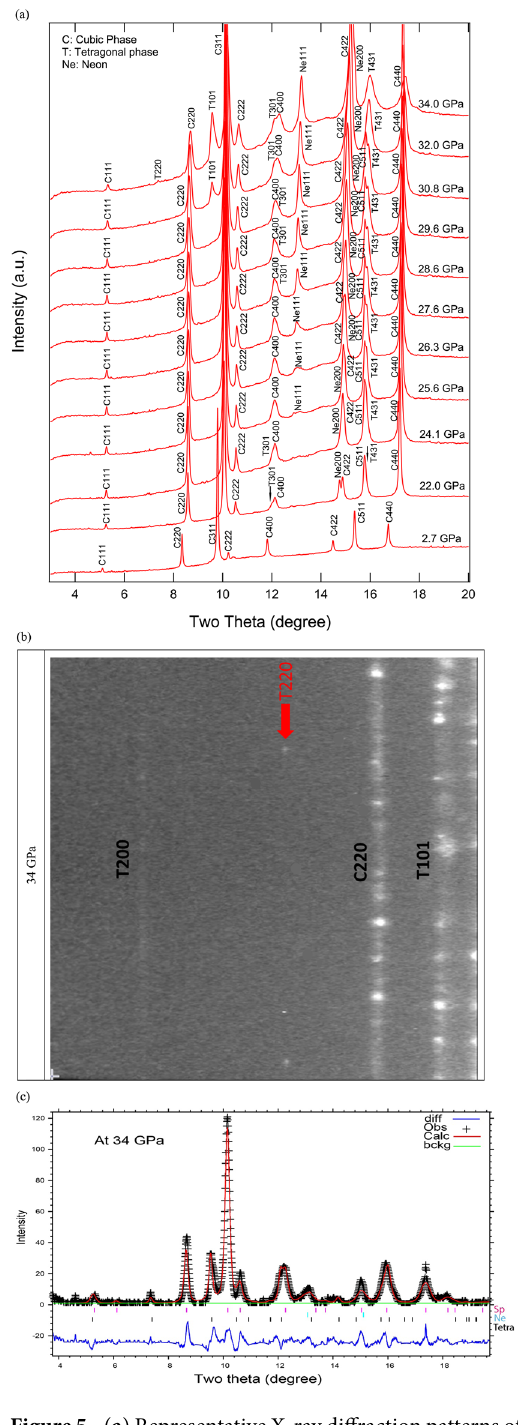
Figure 5. ( a ) Representative X-ray diffraction patterns of Mg 2 TiO 4 collected in Run 2. The high-pressure tetragonal phase coexisted with low pressure phase at 22–34 GPa, but the T101 of high-pressure phase appeared from 32 GPa and T220 appeared at 34 GPa. (b) 2D cake image showing the new T220 pattern at 34 GPa. ( c ) Le Bail refinement of X-ray diffraction pattern at 34 GPa. The ticks represent three calculated structures: Tetra – high-pressure tetrahedral phase, Sp- ambient pressure cubic phase and Ne – pressure